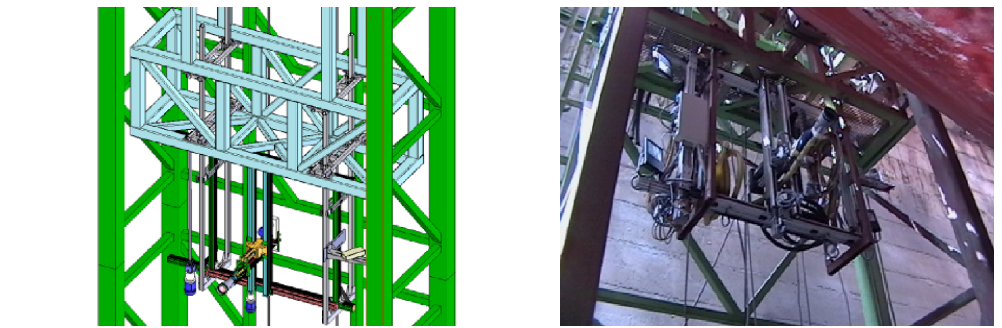
Figure 7. Attachment of the secondary structure.